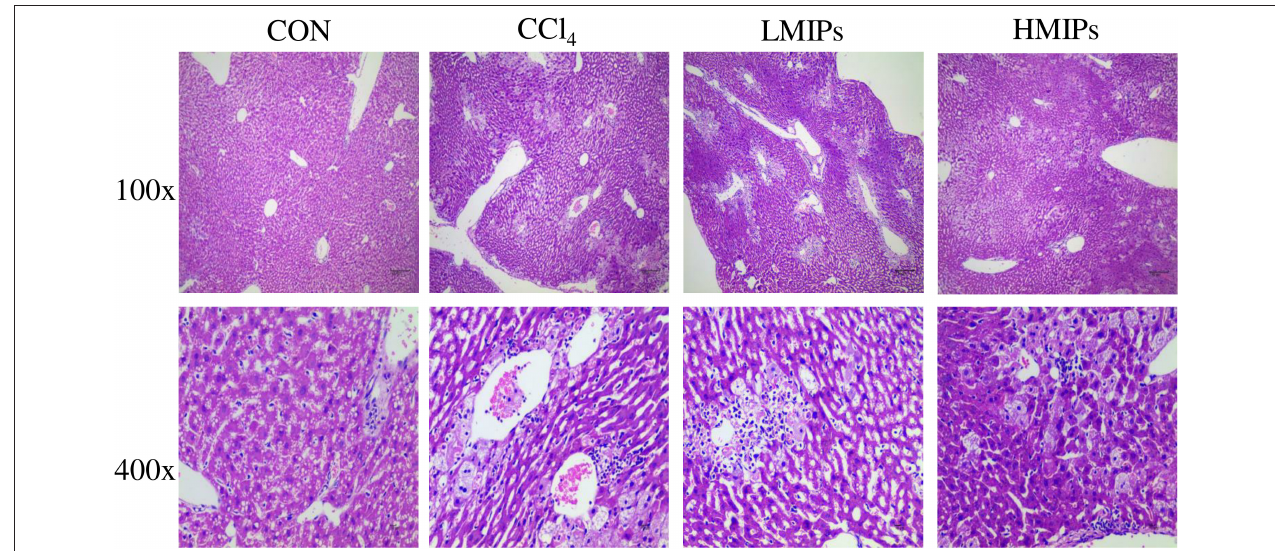
FIGURE 6 | Effect of MIPs on the liver as disclosed by morphological analysis (H and E staining, magnifications of 100 × and 400 × ).